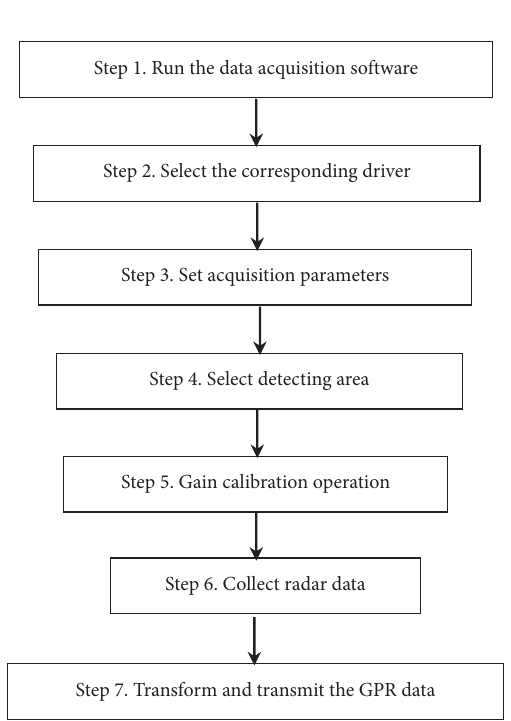
Figure 7: Operation procedure of the GPR field